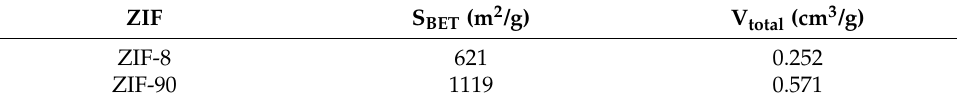
Table 3. BET analysis for both ZIFs showing the specific surface area (S BET ) and total pore volume (V total ).